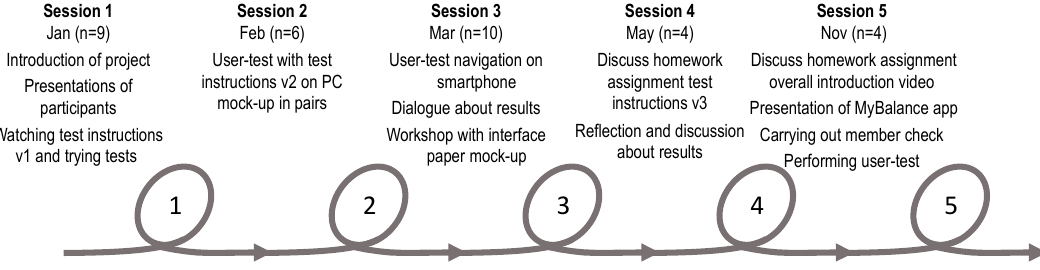
Figure 1. An overview of the design process with tasks from the five co ‐ creation sessions, containing information about each session with number of participants.